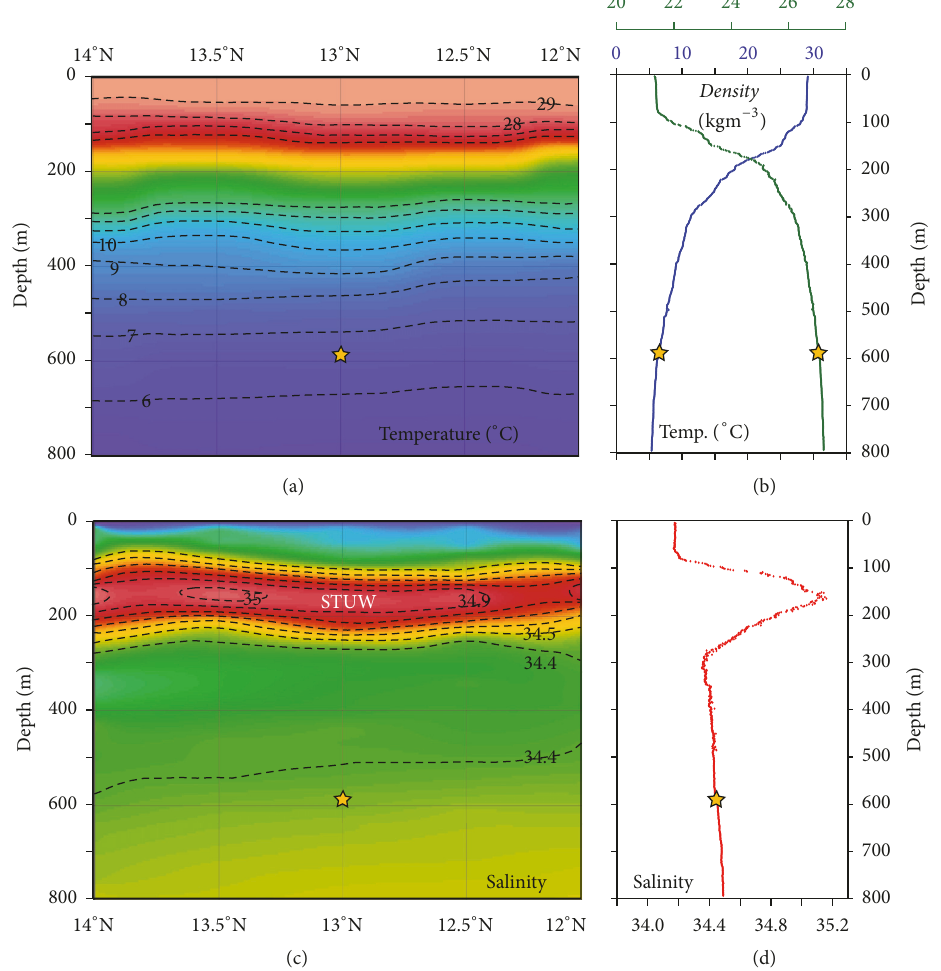
Figure 4: Hydrographic characteristics in the upper 800m in vertical sections plotted from X-CTD data (a, b), and temperature, density, and salinity profiles plotted from data obtained from the CTD onboard the Shinkai 6500 submersible during the dive (c, d) when a ∼ 1m Haliphron atlanticus was video-recorded at depths from 586 to 599 m. The approximate depth/latitude location where the octopus was seen is marked by stars for each parameter. In (a) only isotherm contours mostly outside the thermocline are shown, and in (b) only isohalines mostly associated with the high-salinity Subtropical Underwater (STUW) are